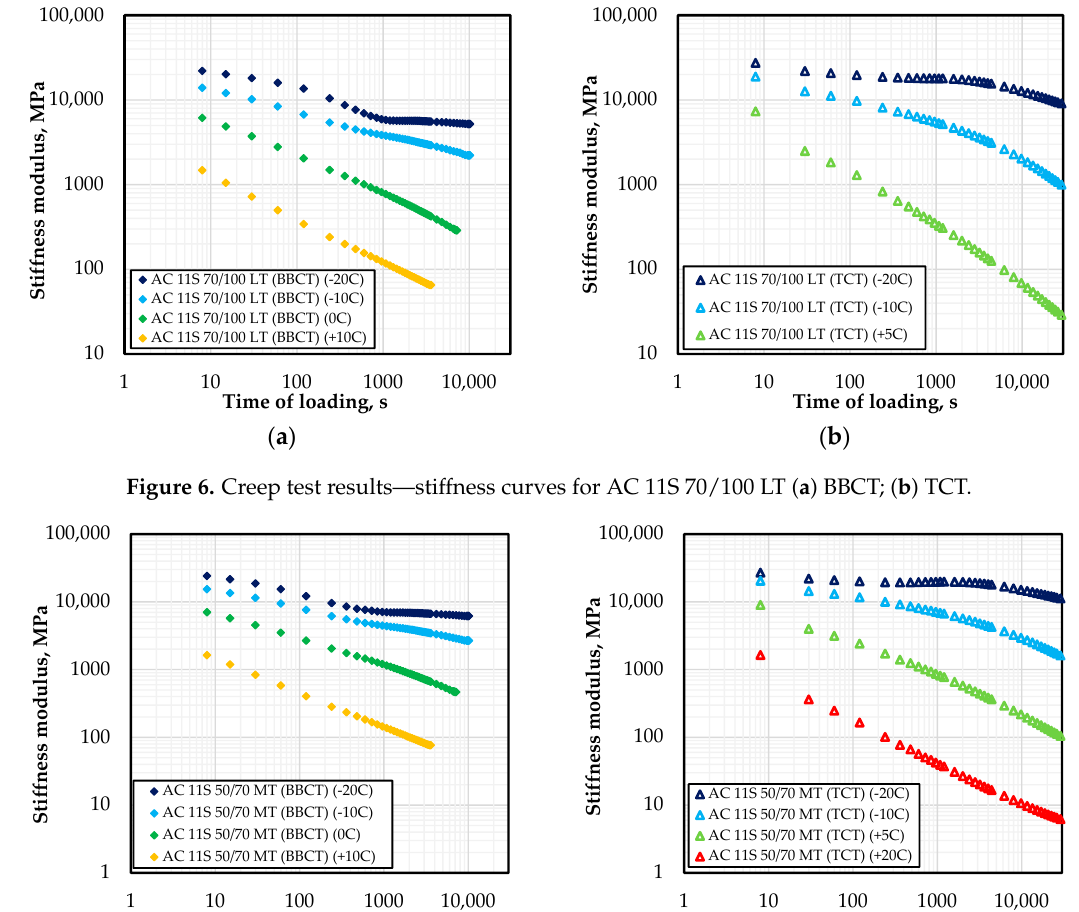
Figure 8. Creep test results—stiffness curves for AC 11W 35/50 MT, only for TCT.